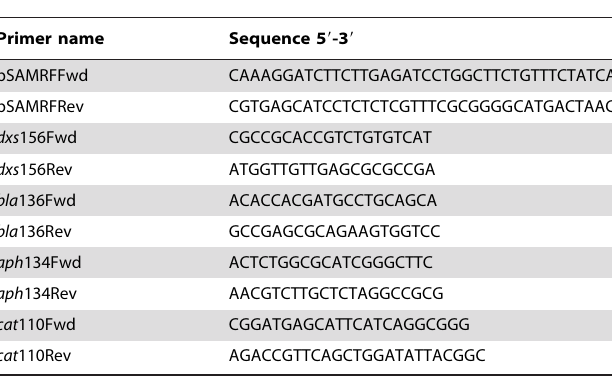
Table 1. Primers used for cloning and